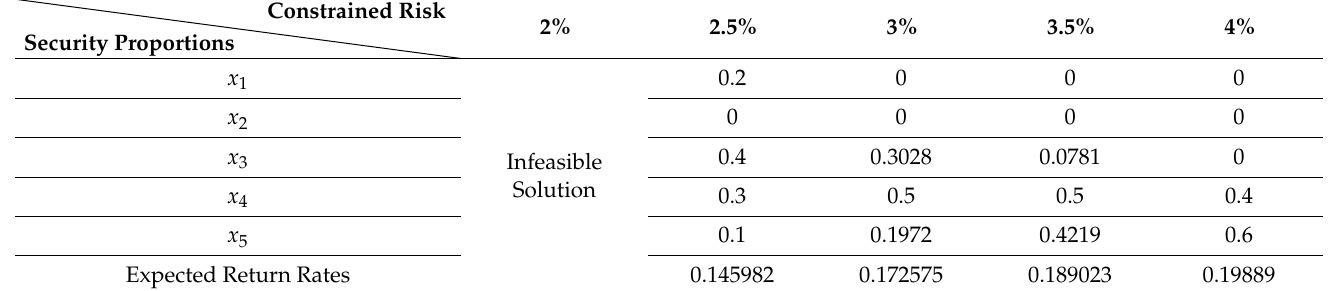
Table 18. The dimension with t = 3 and s = 5 with a guaranteed return rate (cid:101) p 3 in the proposed